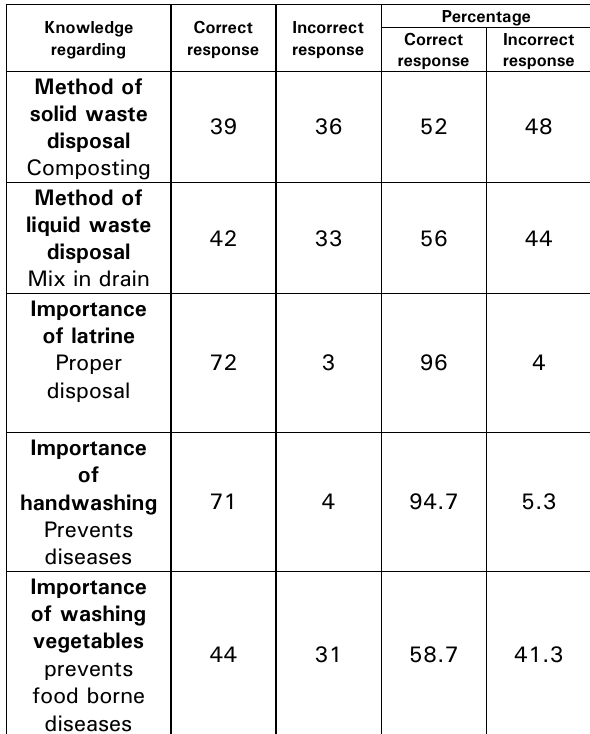
Table 4: Respondent’s knowledge regarding domestic waste management